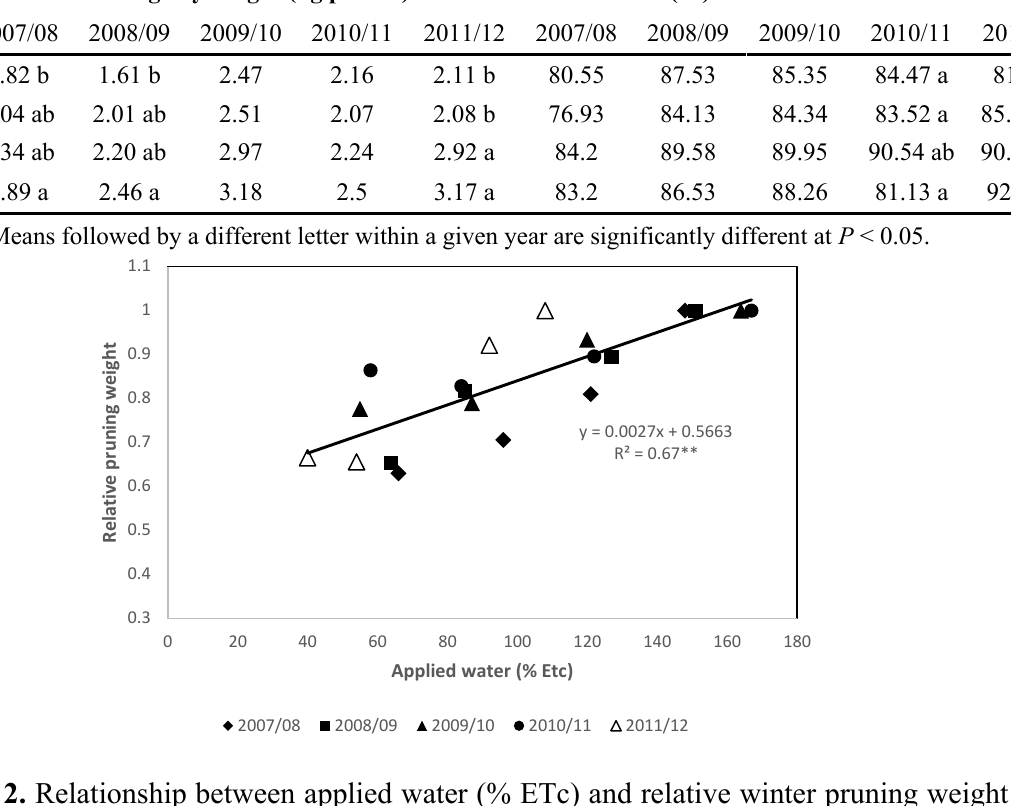
Figure 2. Relationship between applied water (% ETc) and relative winter pruning weight in the different experimental